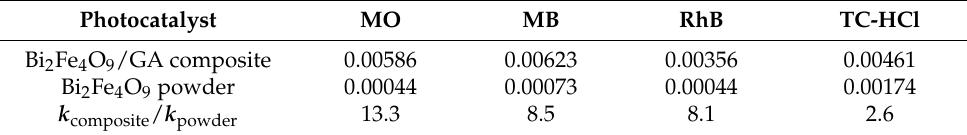
Figure 6. Rate constants of Bi 2 Fe 4 O 9 /GA and Bi 2 Fe 4 O 9 for various dyes and drug. Table 1. Evaluated degradation rate constant k (min − 1 ) on the dyes and drug.